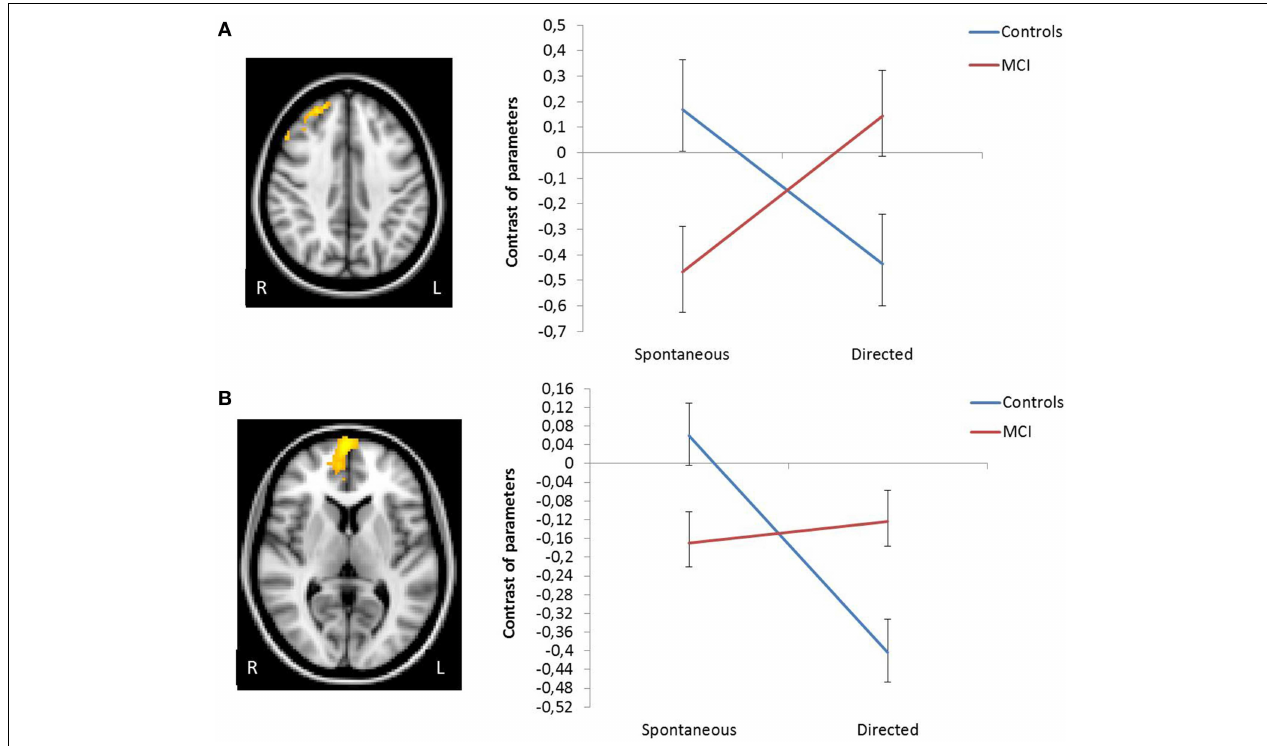
FIGURE 2 | Change in functional activation in the regions of significant group × session interaction showing that in right superior frontal gyrus (A) and in vmPFC (B) there is a decrease in activation in the controls, and an increase in MCIs.